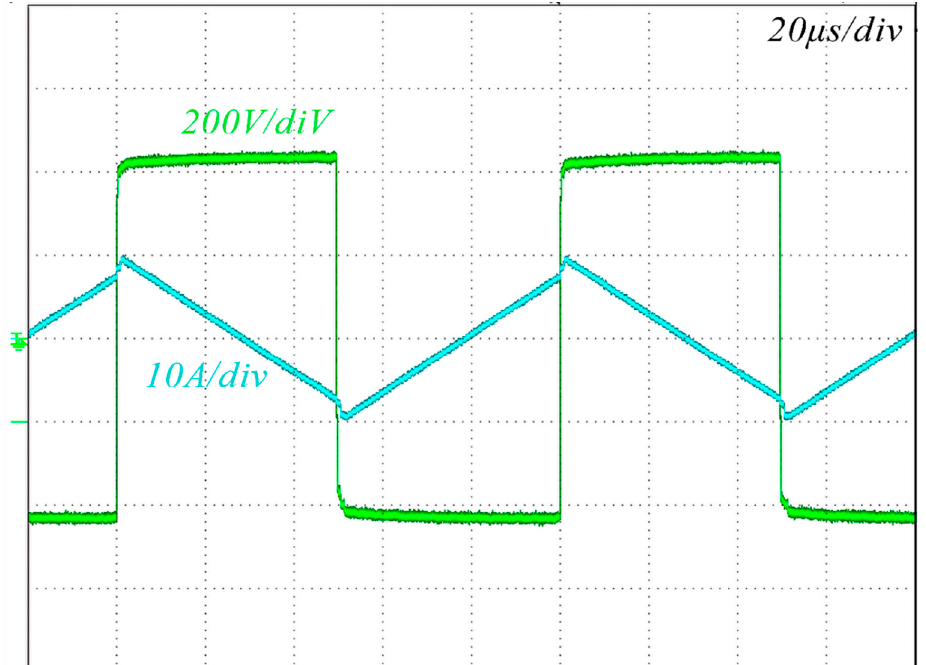
Figure 18. DAB transformer current and applied voltage.